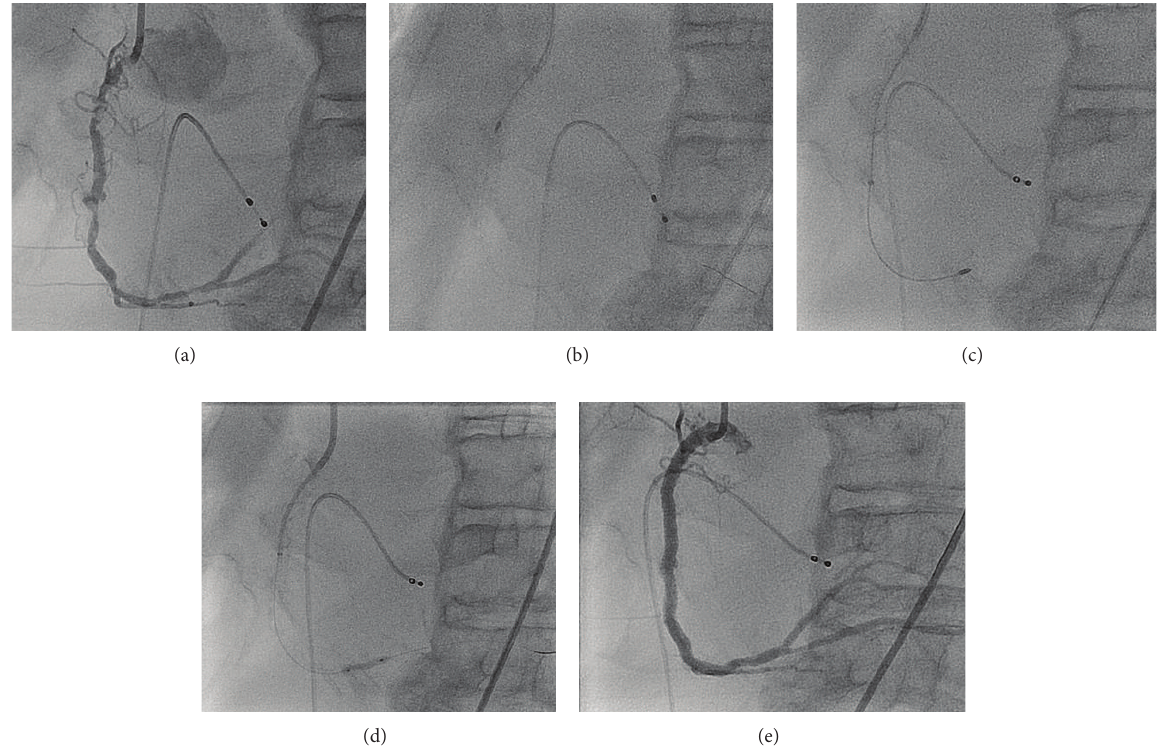
Figure 3: Rotablation of a diffusely calcific tortuous RCA with 7 Fr. GuideLiner. (a) Diffusely calcific RCA showing ostial, mid., and distal severe calcific lesions. (b) Rotablation of the proximal to mid-RCA with difficulty in advancing the Rota. burr in the distal vessel. (c) Advancement of a 1.5mm burr to the distal RCA through a 7 Fr. GuideLiner. (d) Successful lesion expansion with a noncompliant balloon after rotablation. (e) Final angiographic result with distal to ostial drug eluting